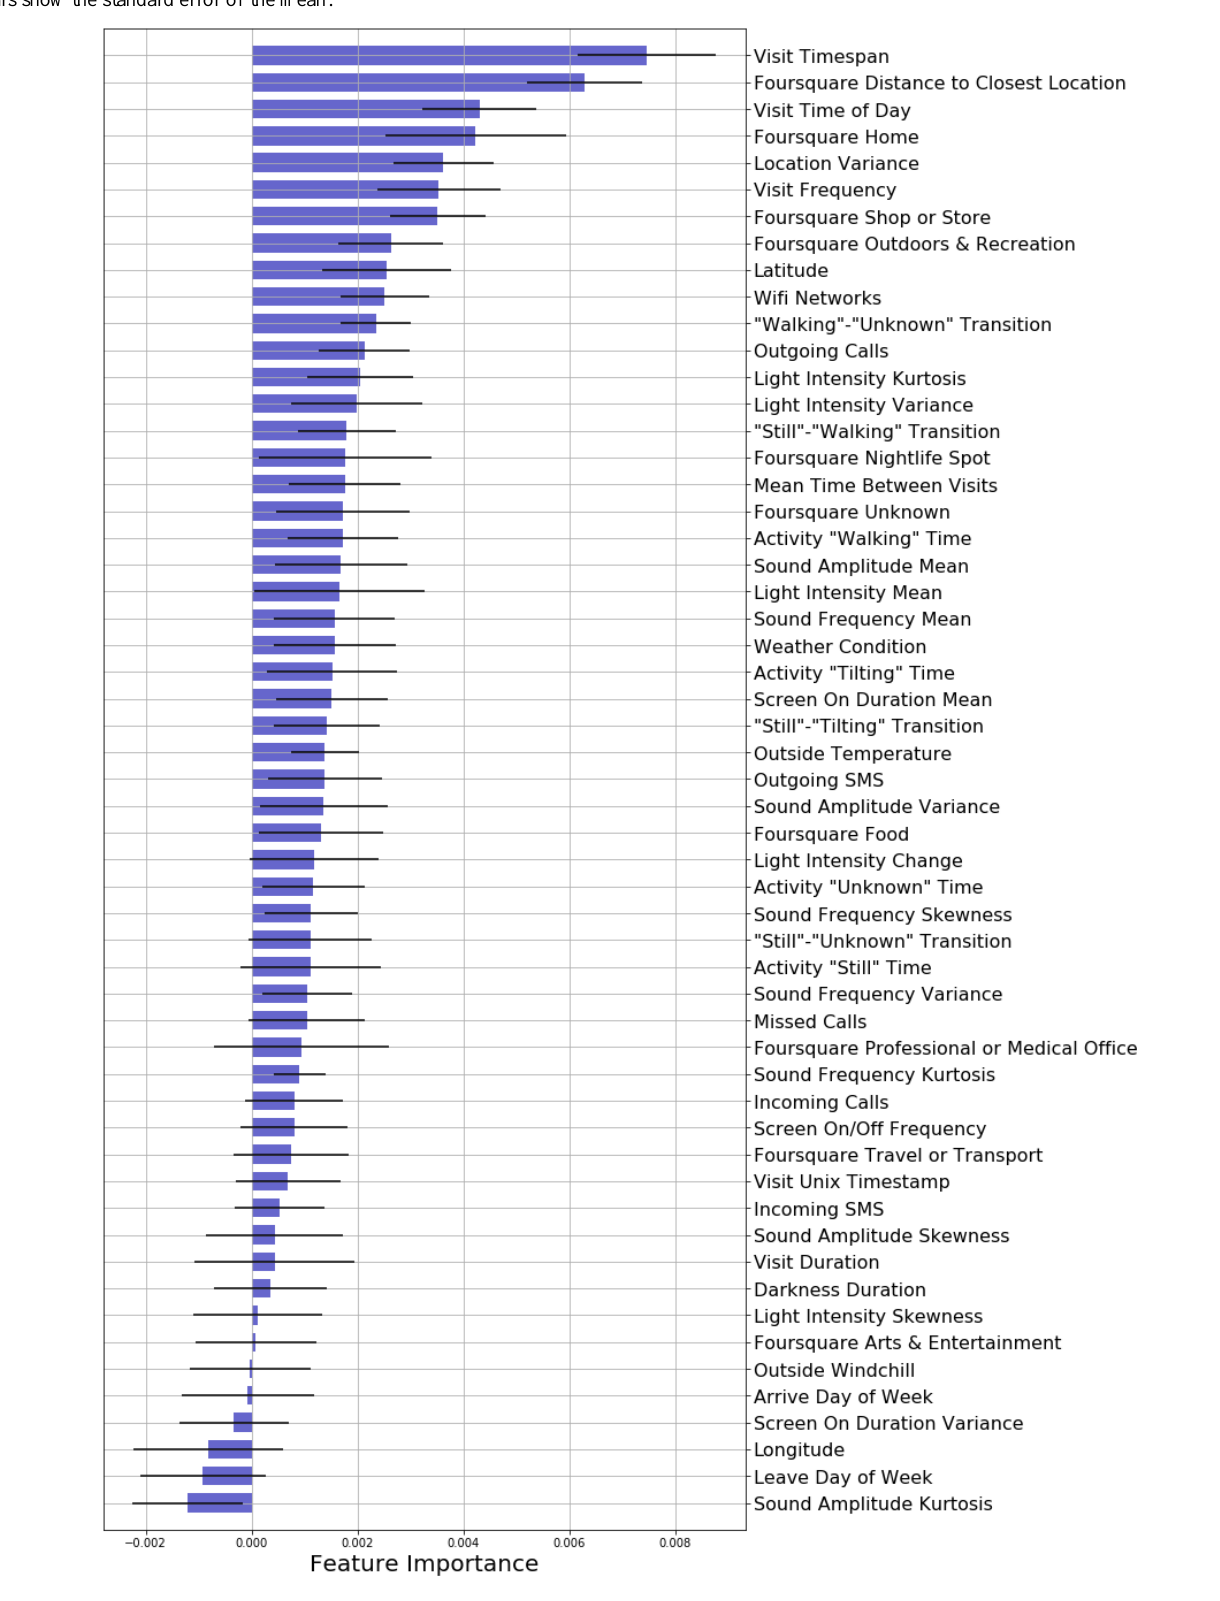
Figure 9. Mobile phone sensor feature importance in detecting semantic locations. Features are sorted based on their importance, from top to bottom. The importance of each feature is calculated by computing the decrease in the cross-validated area under the curve when that feature is removed from the feature set. Negative values indicate an increase in performance. Each value is the mean feature importance across cross-validation folds, and error bars show the standard error of the